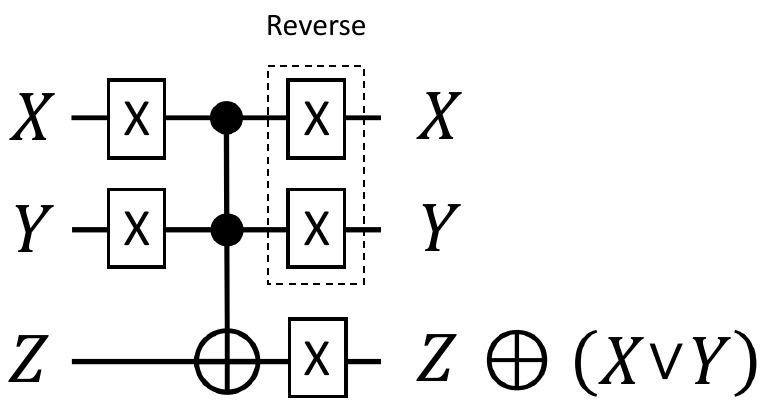
Figure 4. Descriptions: of X gate ( left ); CNOT gate ( middle );and Toffoli gate ( right ). In the Sbox of PIPO block cipher, the OR operation is used. The OR operation can be replaced by a combination of X gates and one Toffoli gate. This is shown in Figure 5. To calculate the OR result of X and Y , X gates should be executed before performing the Toffoli gate. Then, the Toffoli gate is performed and the OR result is stored in Z . If input values ( X and Y ) are needed, the reverse operation should be performed. In quantum circuits, reverse operations are used to perform certain operations again and return them to their original states.